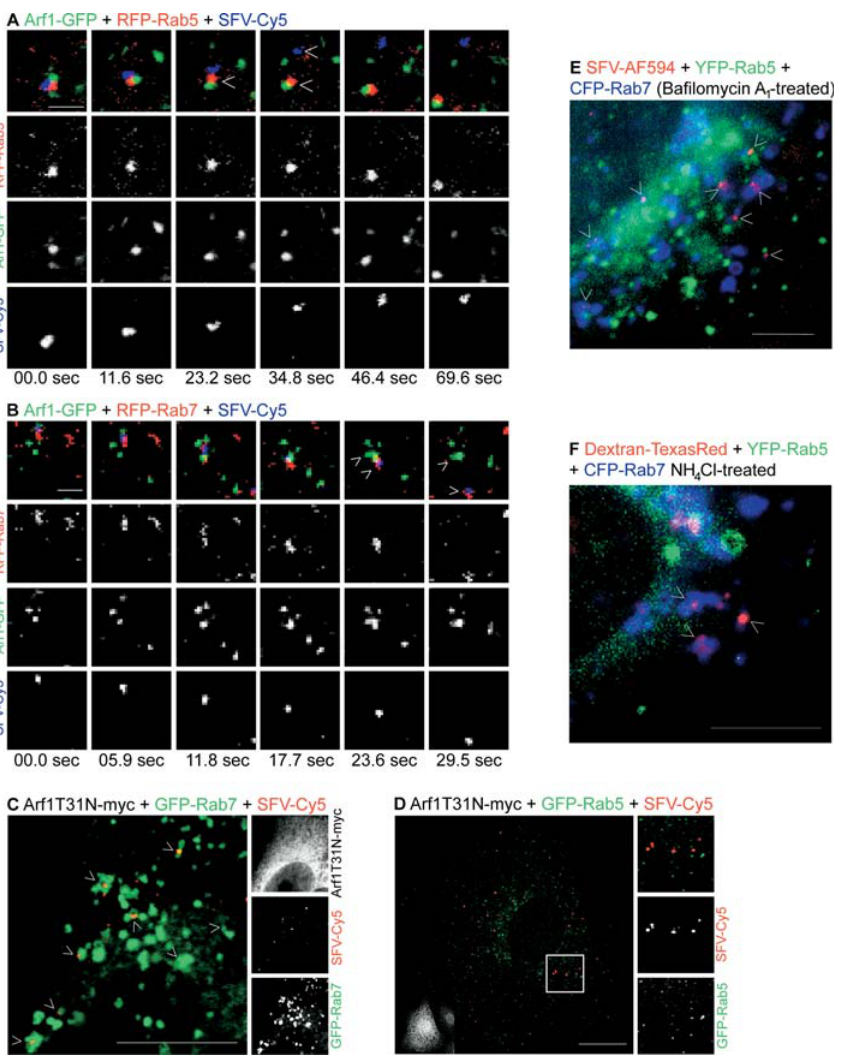
Figure 6. Sorting of SFV into Late Endosomes is Arf1- and pH-Independent (A and B) Selected images, obtained from time series recorded approximately 20 min after warming. Vero cells were transfected with (A) Arf1-GFP and RFP-Rab5, or (B) Arf1-GFP and RFP-Rab7, then SFV-Cy5 was added. Arf1 is present on Rab5-positive endosomes. SFV-Cy5 is sorted away from Arf1- and Rab5-positive endosomes in a Rab7-positive vesicle (arrowheads). Scale bars represent 2.5 l m. (C and D) Confocal microscopy of a Vero cell transfected with GFP-Rab7 (green in [E]) or GFP-Rab5 (green in [D]) and Arf1T31N-myc and incubated with SFV-Cy5 (red). Cells were fixed, permeabilized, and immunostained using an antibody against myc-tag (9E10) after 1 h of internalization. SFV-Cy5 is not present in Rab5 but is present in Rab7-positive endosomes (arrowheads), indicating that Arf1 is not needed for the sorting of SFV into Rab7-positive endosomes. Scale bars represent 10 l m. (E) Wide field fluorescence image of Bafilomycin A 1 –treated (25 nM) Vero cells expressing YFP-Rab5 and CFP-Rab7, at 2 h after internalization of SFV- AF594. SFV is present in Rab7-positive endosomes (arrowheads), indicating that no acidic pH is needed for the sorting of SFV into Rab7-positive endosomes. Scale bar represents 5 l m. (F) NH 4 Cl-treated (20 mM) Vero cells expressing YFP-Rab5 and CFP-Rab7 incubated with Dextran–Texas Red for 2 h. Dextran is present in Rab7-positive endosomes (arrowheads), indicating that no acidic pH is needed for the sorting of SFV and Dextran into Rab7-positive endosomes. Scale bar